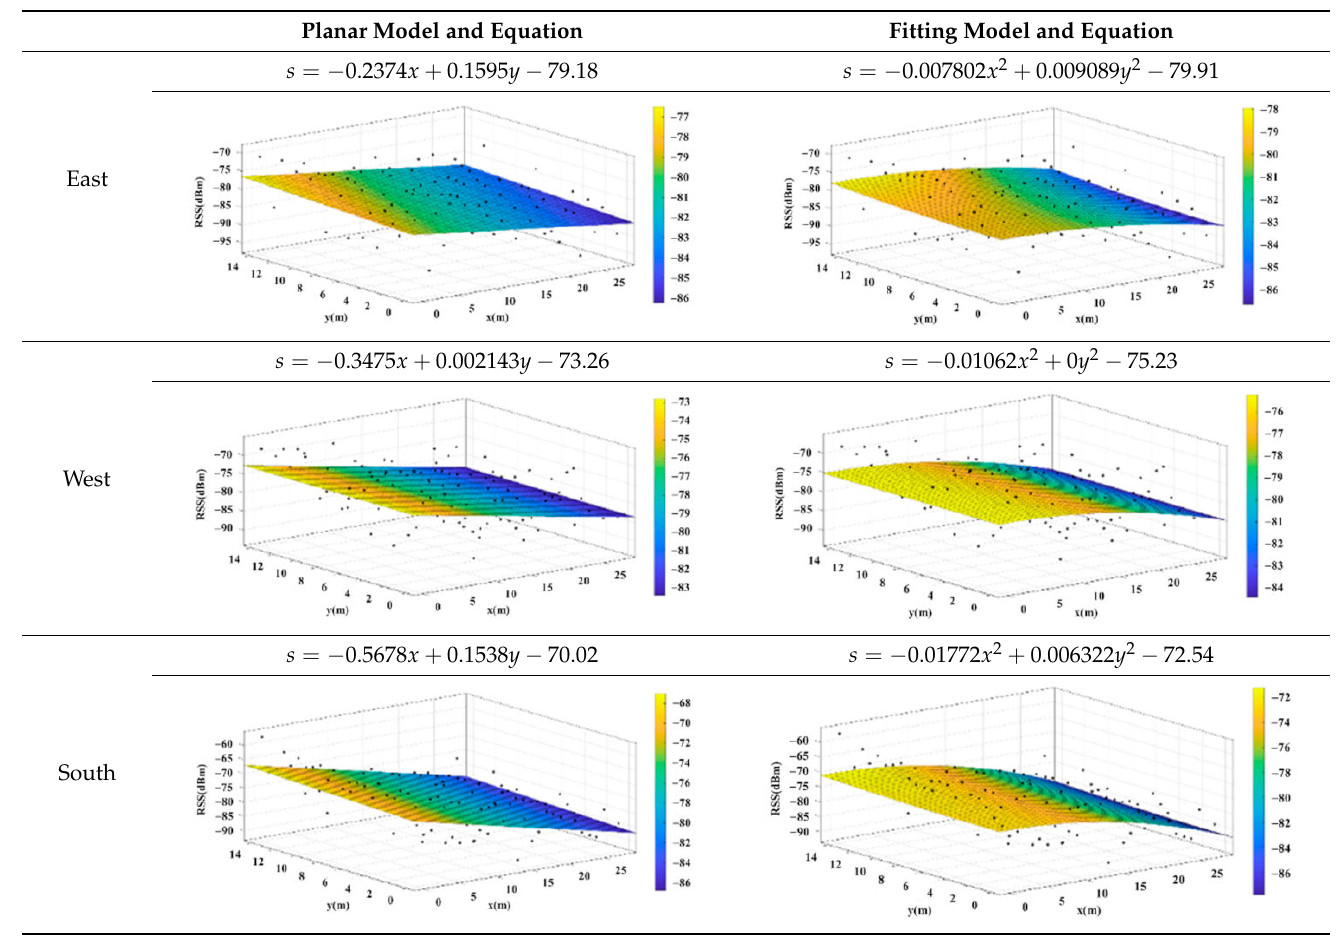
Table 5. Models and Equations Generated from the Four Directions in the Experimental Environment for Base Station